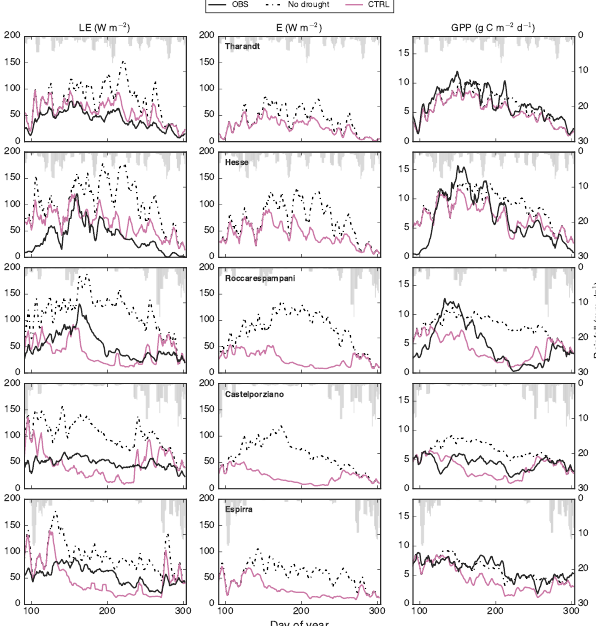
Figure 1. A comparison of the observed (OBS) and modelled (CTRL) Latent Heat (LE) and transpiration ( E ) at five Fluxnet sites during 2003. The data have been smoothed with a 5-day moving window to aid